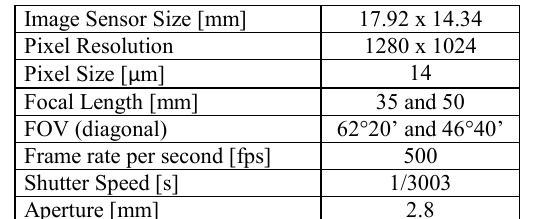
Table 1. Main characteristics of the high-speed cameras and settings used during the testing.